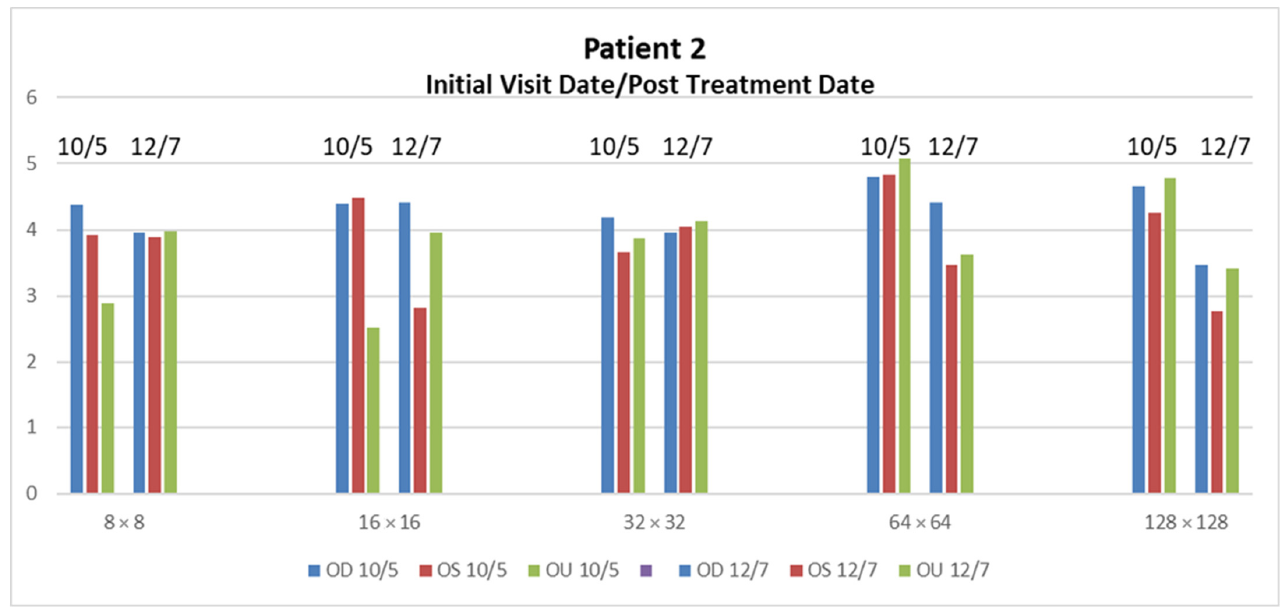
Figure 4. PSD reduction after two months in Patient 2 is seen in 64 × 64 OS and OU, and 128 × 128 OD, OS and OU. The restoration of PSD values for these specific areas within the 2–3 range have shown to contribute to the measurement of improvement of visual issues from mTBI.